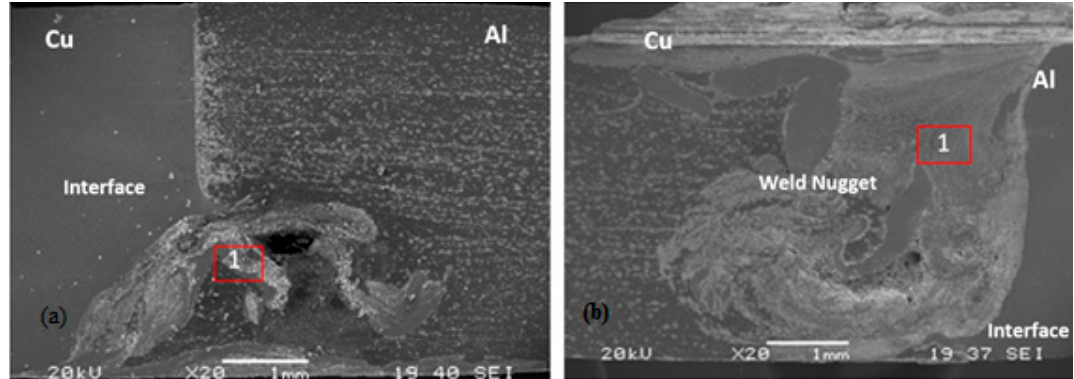
Figure 18. SEM images of ( a ) 630/50/1 specimen; ( b ) 1330/20/1 specimen.